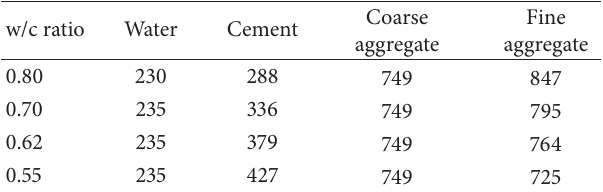
Table 2: Mixture design